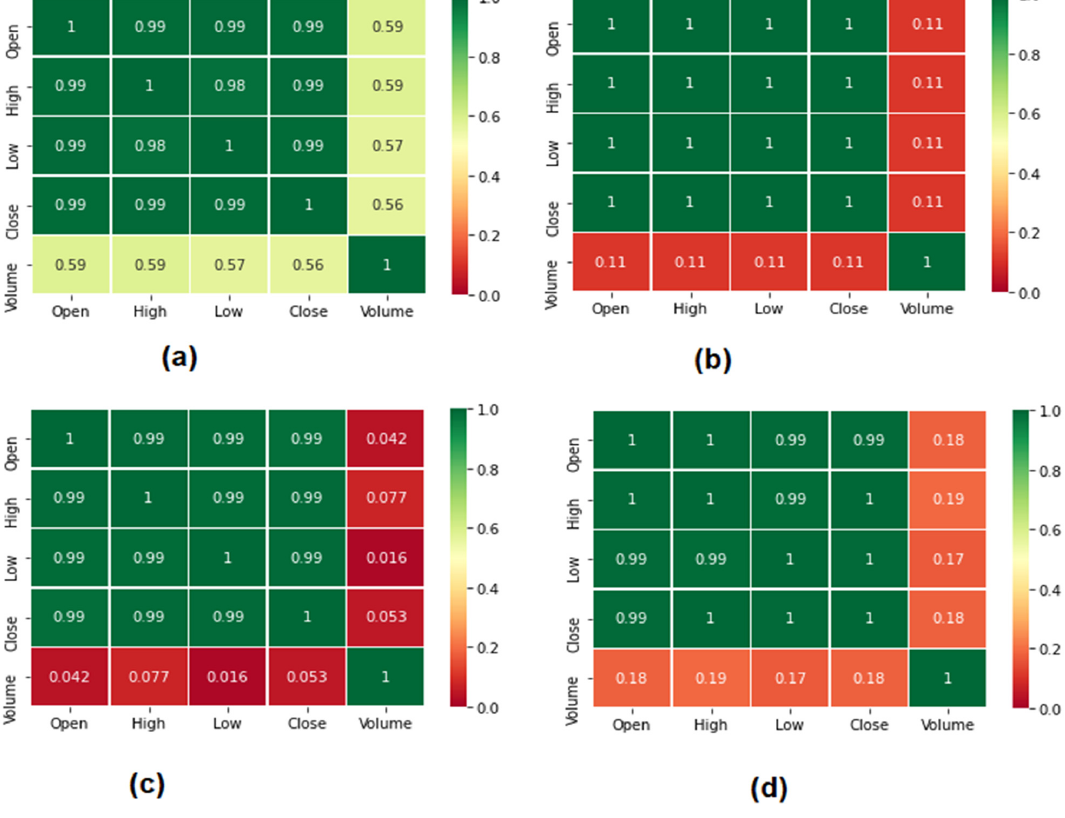
Figure 18. Pearson correlations between the features of the cryptocurrencies ( a ) AMP ( b ) Ethereum ( c ) EOS ( d ) XRP. Table 11. Comparison results between the proposed system and the existing models. Reference Model Currency Results [52]